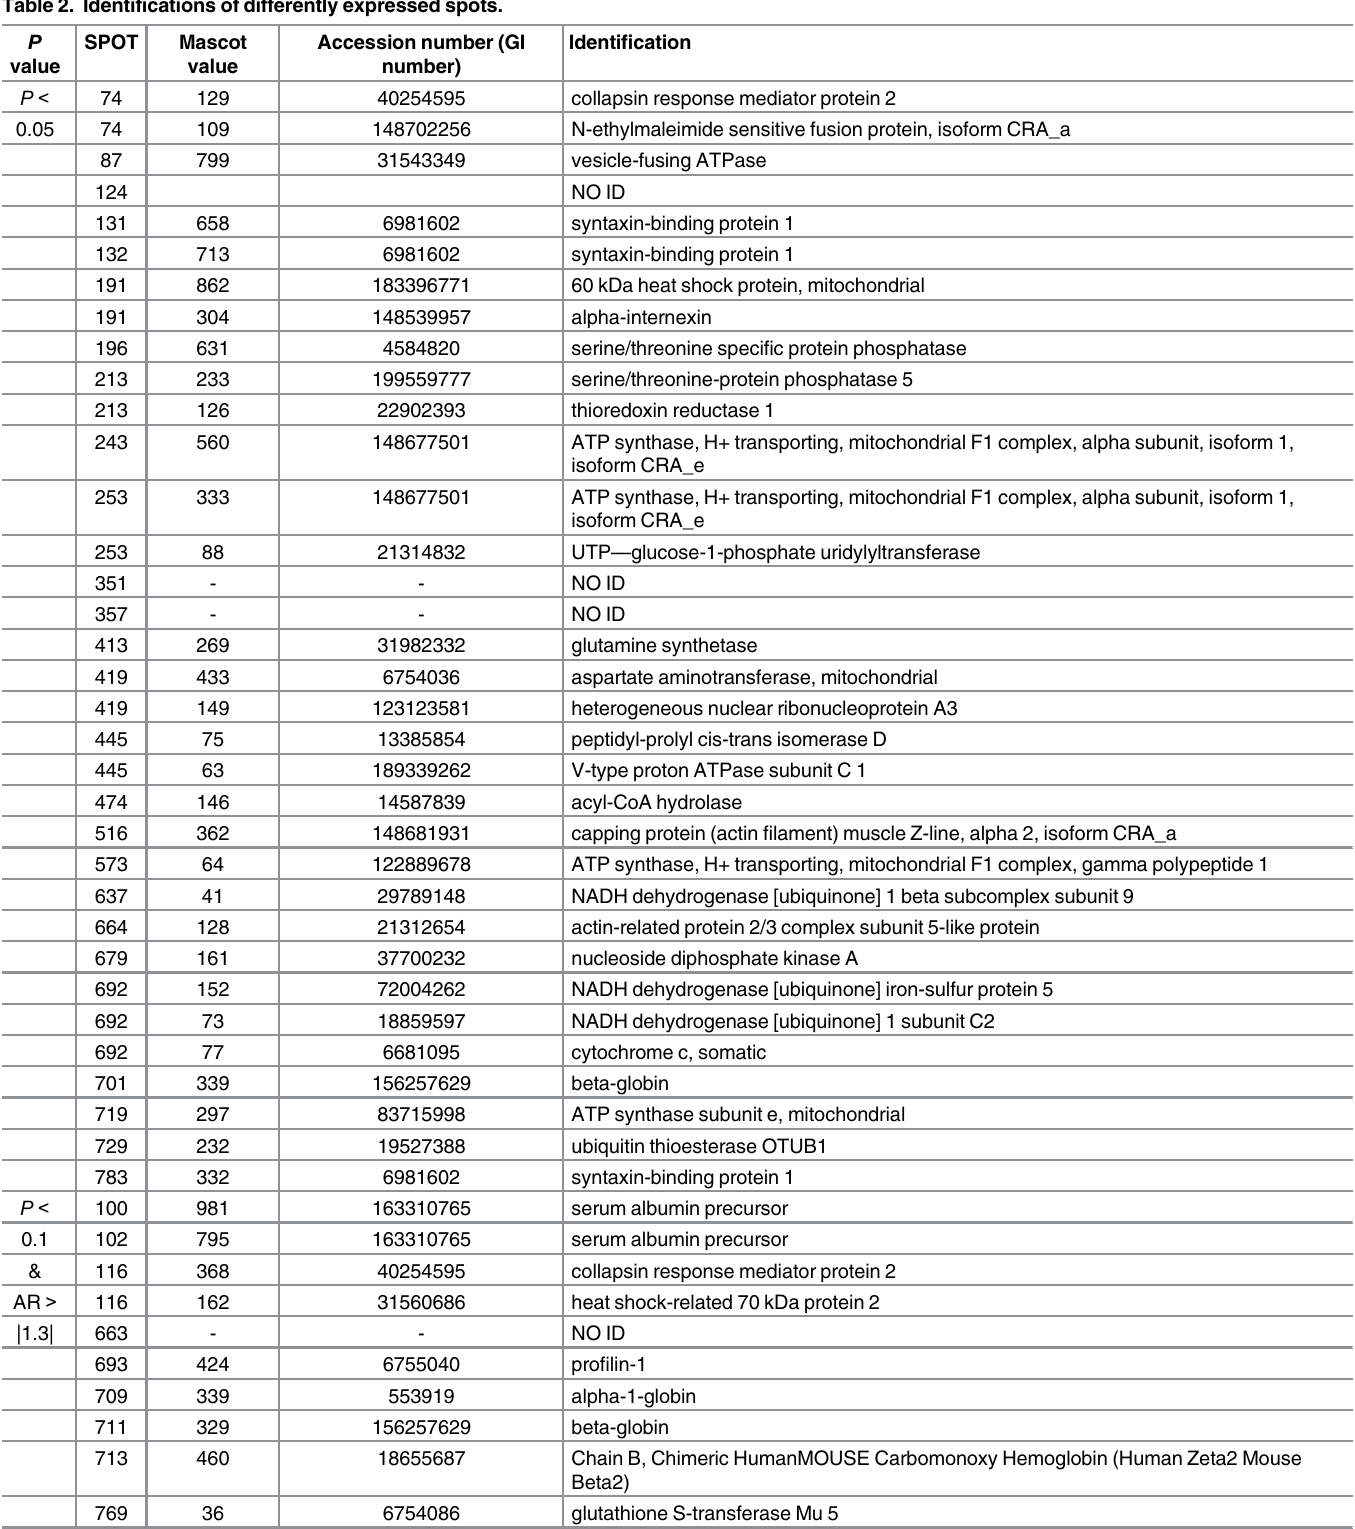
Table 2. Identifications of differently expressed